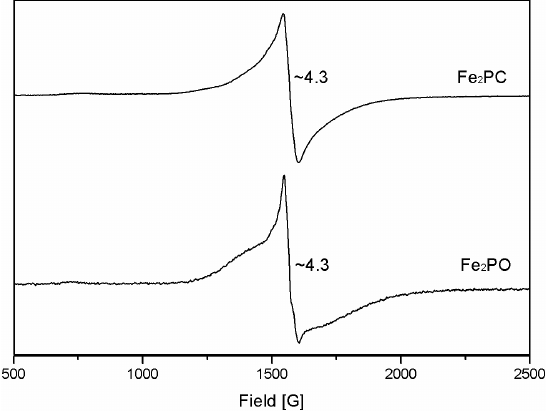
Figure 2. g values of the X-band EPR spectra for Fe conditions: methanol/water (6:4) matrix, temperature 6 K, microwave frequency 9.338 GHz, modulation 1